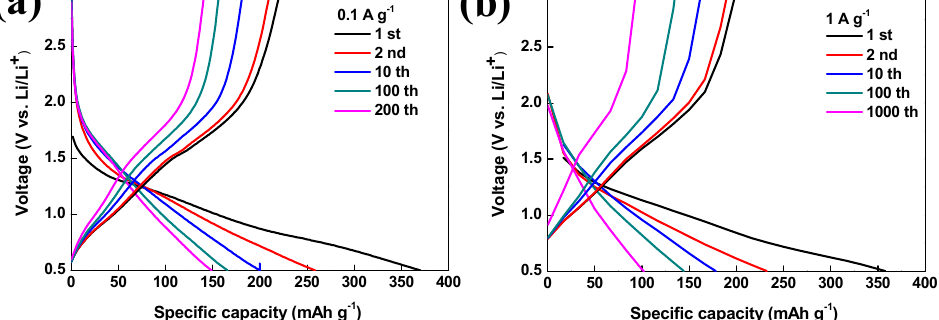
Figure 6. The charge/discharge profile of K 4 Nb 6 O 17 -C-800 with the current density of ( a ) 0.1 and ( b ) 1 A g − 1 at ambient temperature.